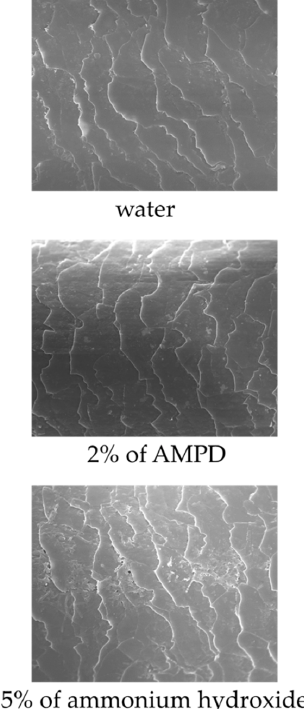
Figure 7. FE-SEM observations of the surface of human hair after using ammonium hydroxide or AMPD aqueous solution as an alkaline agent (×2000). Top: the surface of human hair immersed in pure water; middle: the surface of human hair after using 2% AMPD aqueous solution as an alkaline agent; bottom: the surface of human hair after using 5% ammonium hydroxide as an alkaline agent.